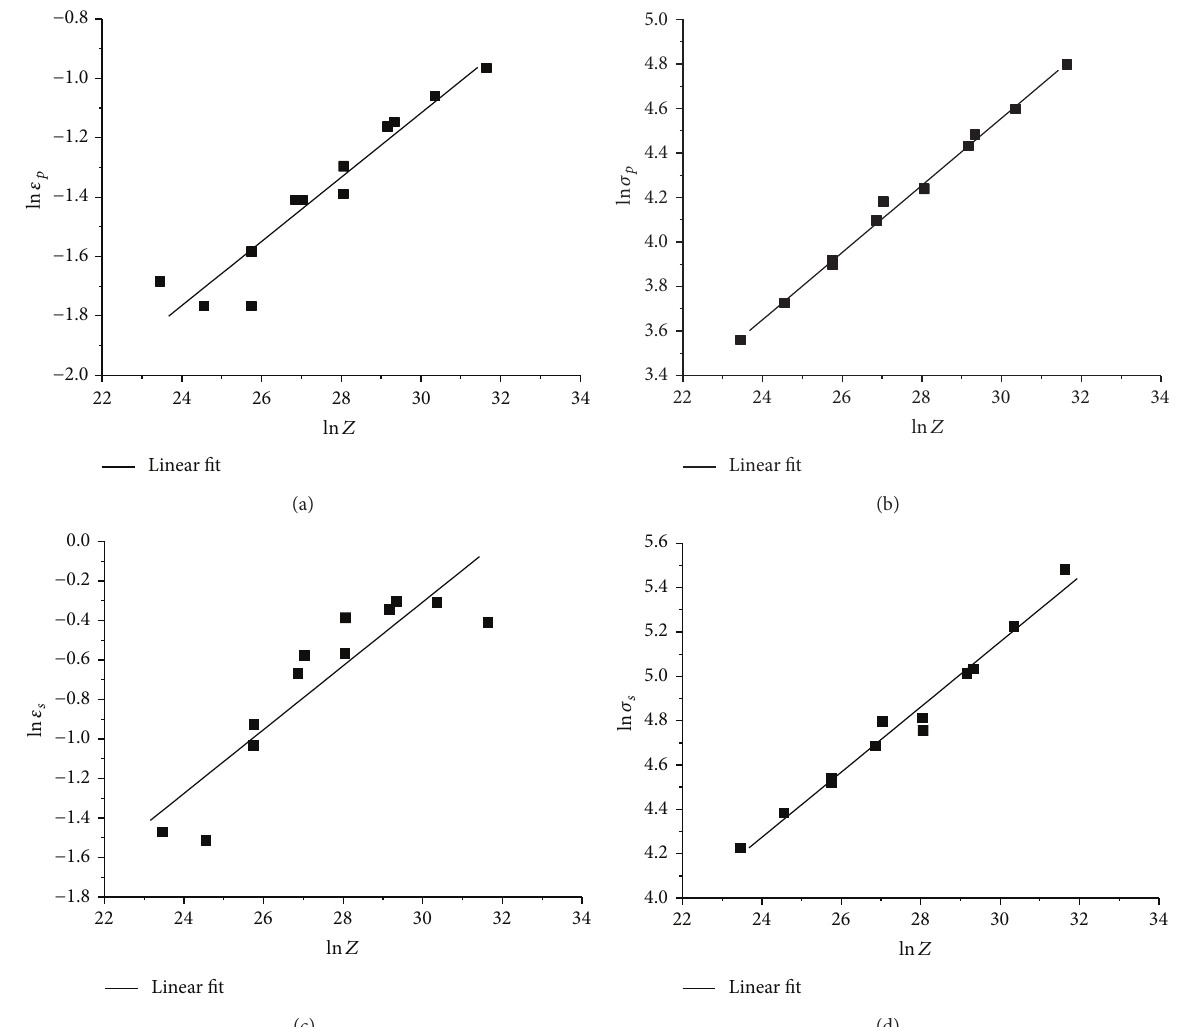
Figure 4: Relationships between (a) ln 𝜀 𝑝 and ln 𝑍 , (b) ln 𝜎 𝑝 and ln 𝑍 , (c) ln 𝜀 𝑠 and ln 𝑍 , and (d) ln 𝜎 𝑠 and ln 𝑍